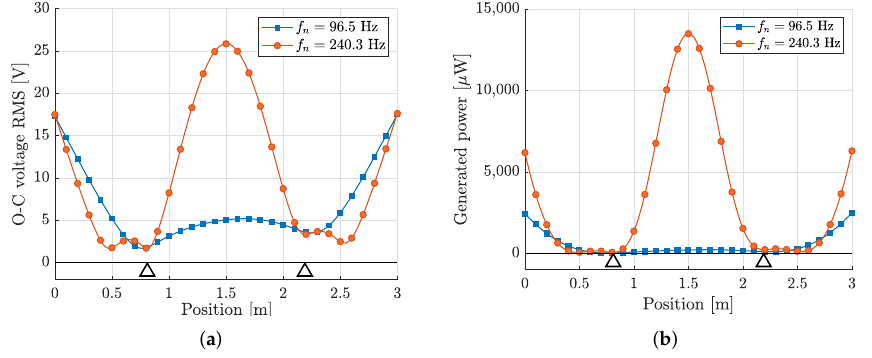
Figure 17. Performance of the piezo-cantilever harvester as a function of tuning and position: ( a ) RMS values of the generated OCV; ( b ) generated